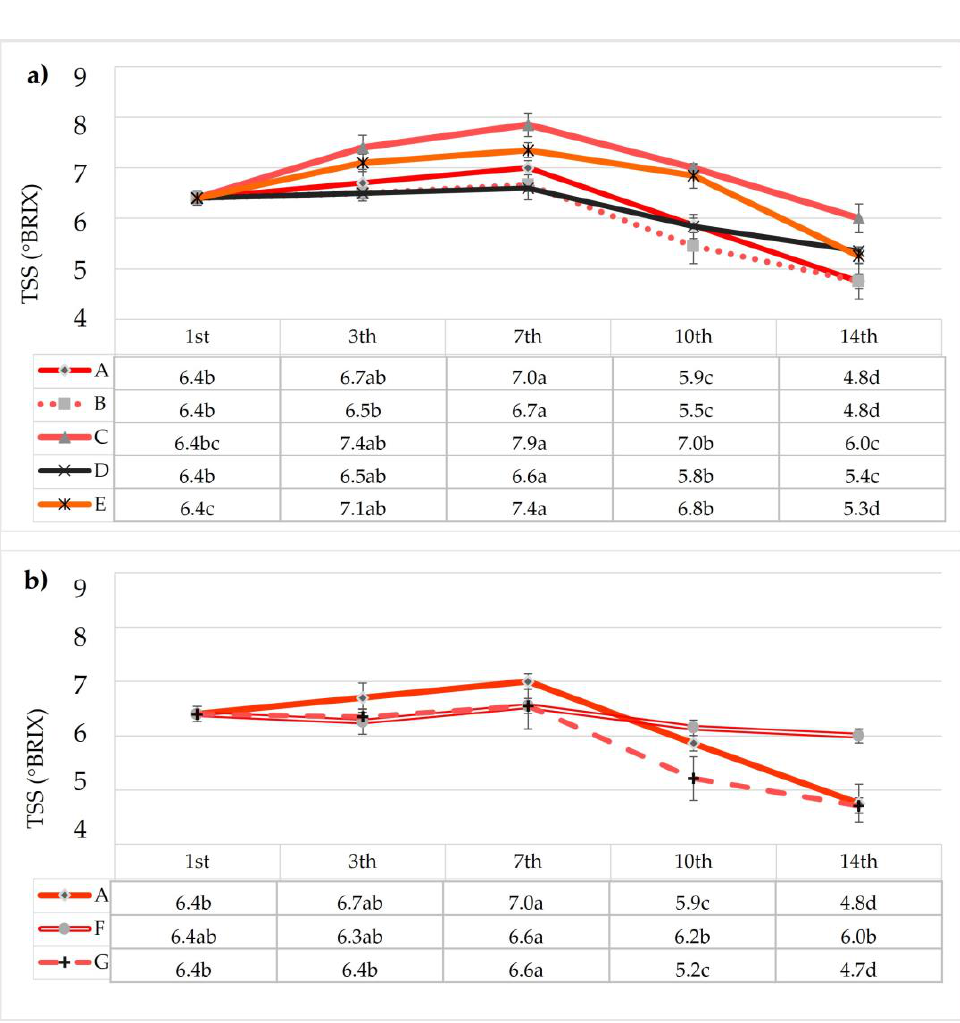
Table 7. The pH, TA (% citric acid), and organic acid contents (ascorbic acid, AA; mg 100 g −1 ; citric acid, CA; mg 100 g −1 ) of strawberries.